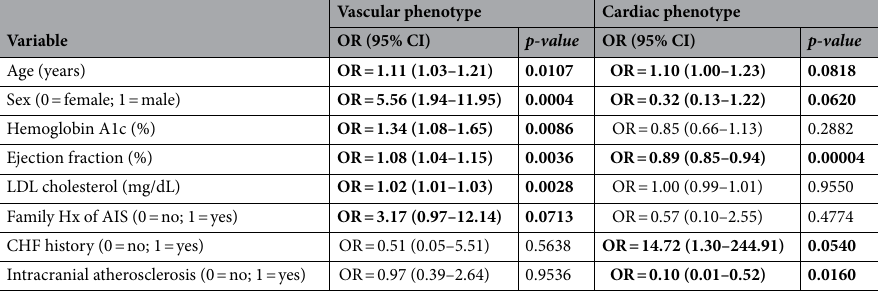
Table 3. Significant variables from multivariate regression of vascular (lacunar and LAA) and cardiac (CE) stroke groups. Bold values reflect variables with p-values < 0.1.